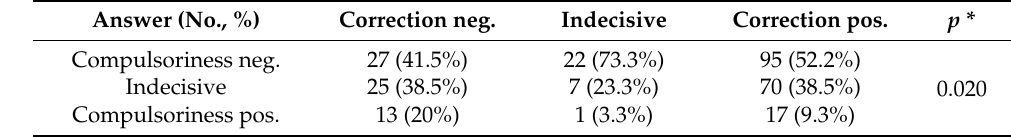
Table 6. Patients’ distribution according to answers provided for Items 7 and